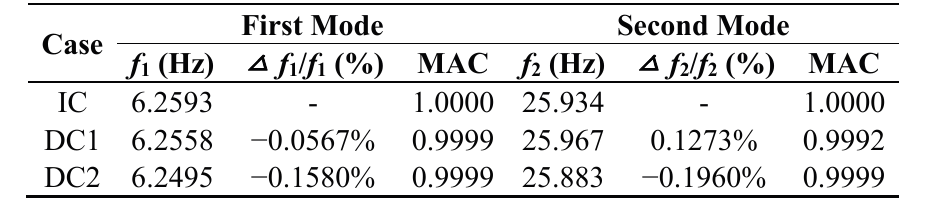
Table 3. Changes in the modal parameters due to damage.